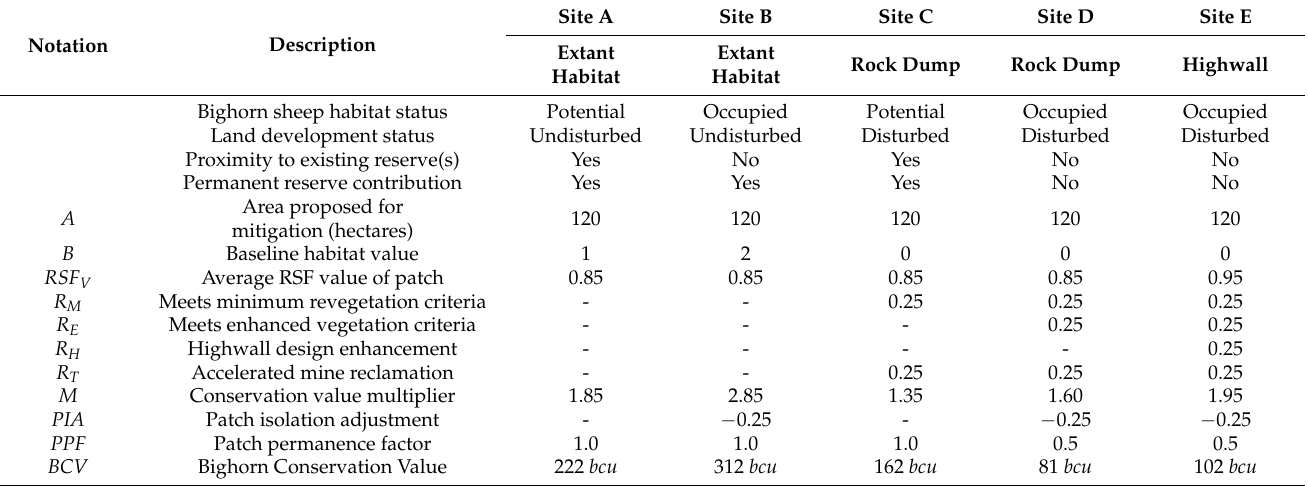
Table 3. Bighorn Conservation Value ( BCV ) of reserve contributions *, expressed as bighorn conser- vation units ( bcu ), for five hypothetical mitigation sites on a landscape transformed by historic or ongoing mining activity. All contributions of habitat enhanced to benefit bighorn sheep are made up front before new disturbance begins, earning additional mitigation